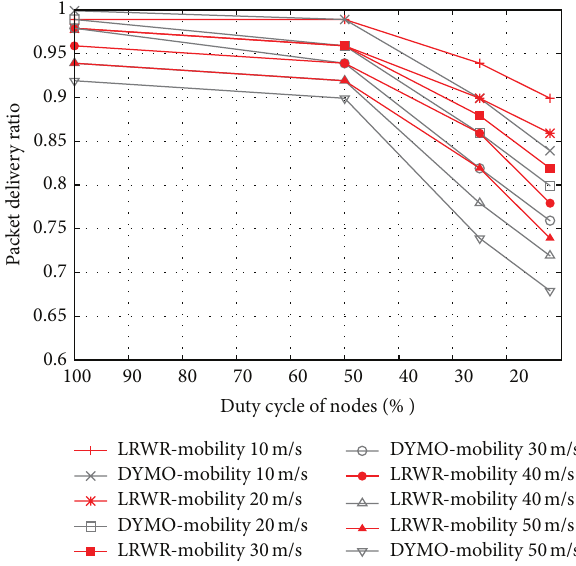
Figure 11: Packet delivery ratio versus duty cycle of